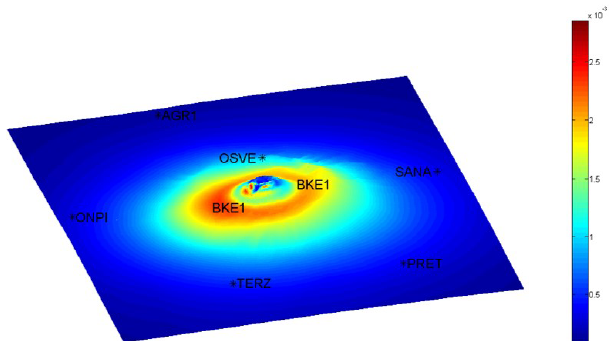
Figure 4. Map of vertical displacements produced by a source lo- cated at 2km depth embedded in heterogeneous medium obtained by evaluating, at each node of the mesh, E and σ with Eqs. (5) and (6). The names and locations of continuous GNSS stations are shown.